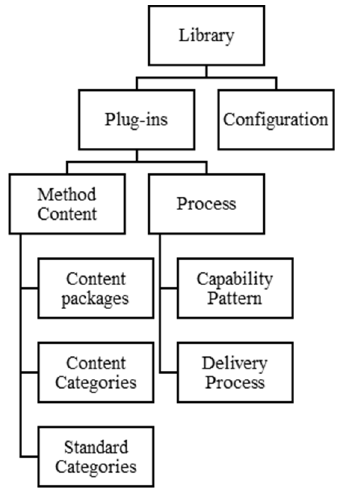
Figure 4. The structure of a process library from EPF.